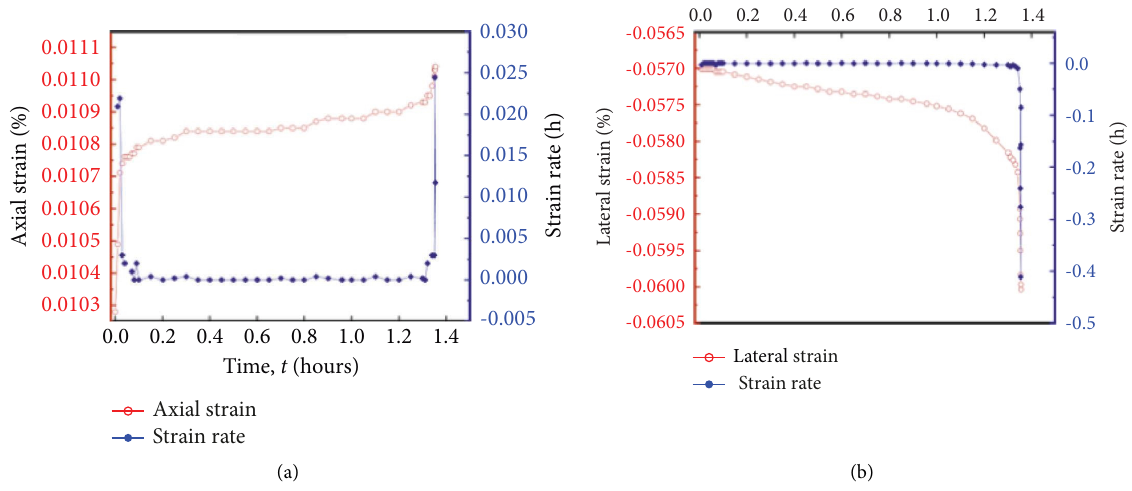
Figure 7: Creep strain and the associated creep strain rate of the sample after oil erosion at the fnal stress